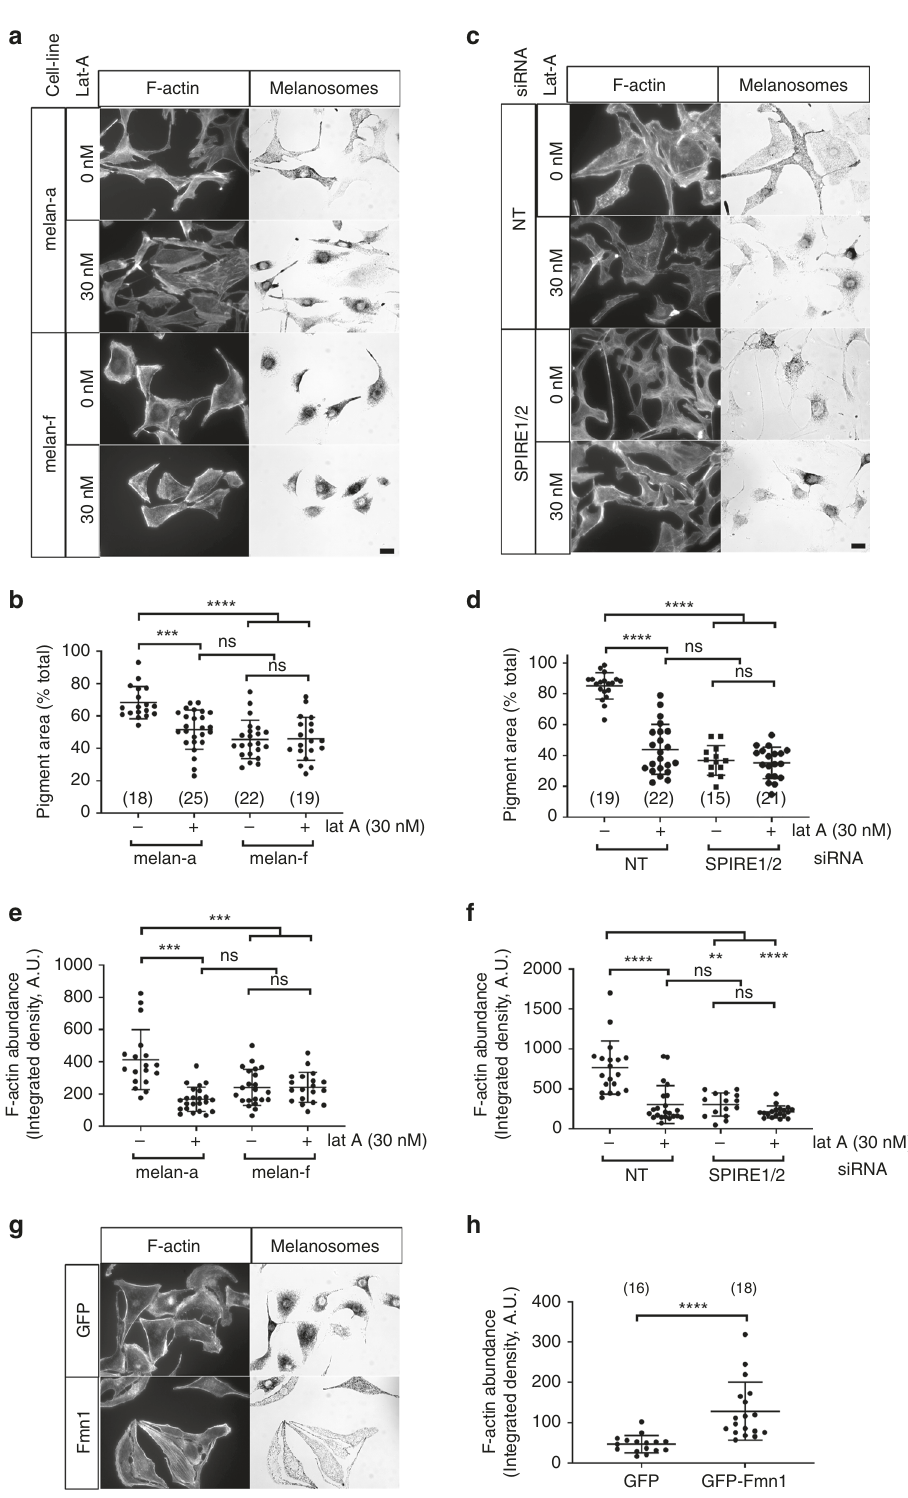
differences in the melanosome-associated AFs, we further measured fi lament length of fi laments emanating from melano- somes in FESEM images (Fig. 3k – m), con fi rming signi fi cantly shorter melanosome-associated fi laments in melan-f cells. (Fig. 3m; mean fi lament length in nm ± SD: melan-a = 261.7 ± 160.6 (median = 223, n = 433) versus melan-f = 116.1 ± 72.32 (median = 103; n = 443); p < 0.0001). Similar differences in AF density and dimensions were observed in melan-a cells